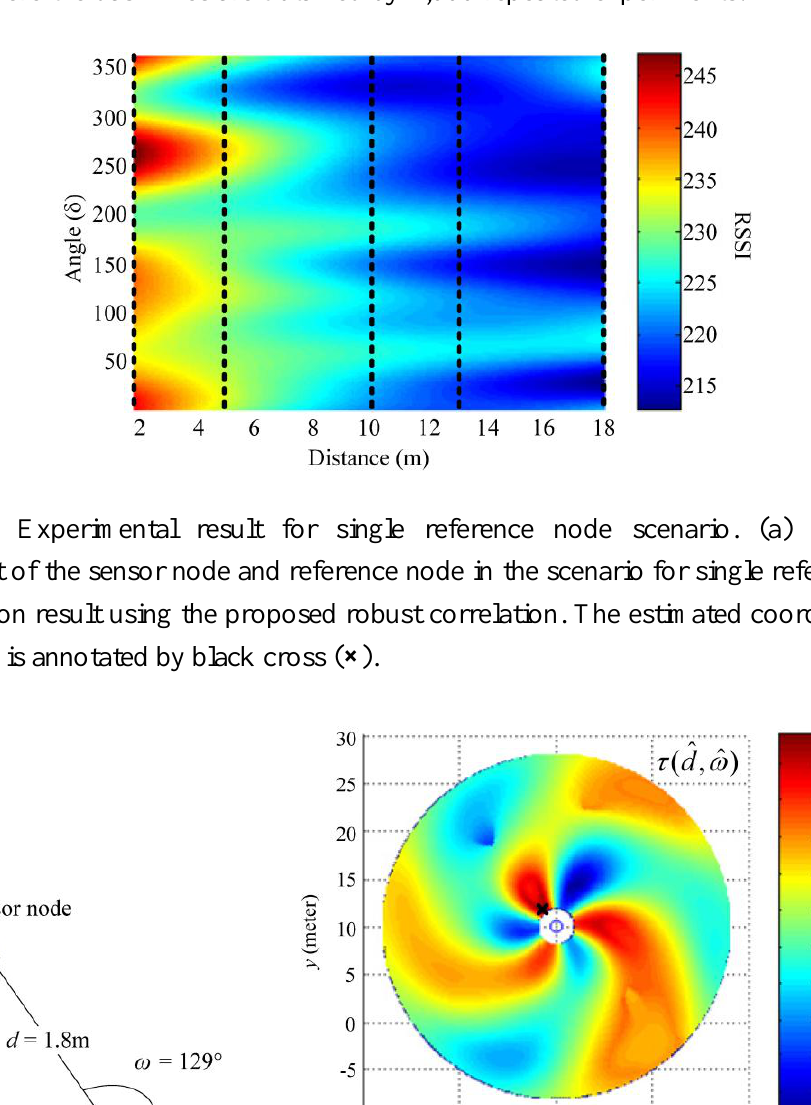
Figure 12. Reference standard RSSI pattern measured from the experiment in a real-world scenario, where the dash lines are obtained by 1,000 repeated experiments.